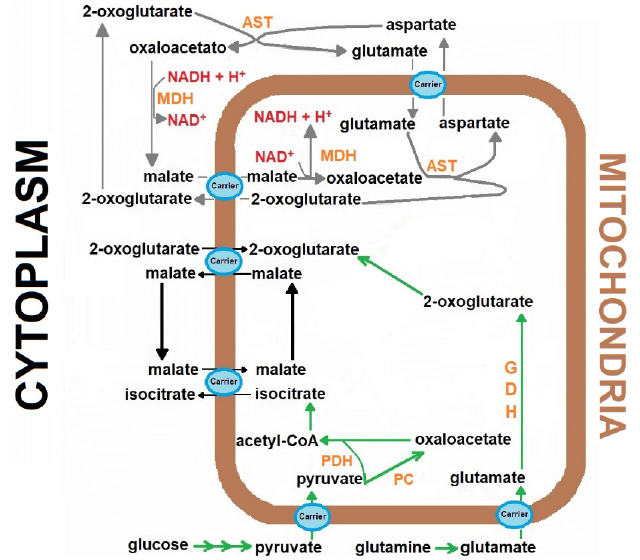
Figure 1. The role of the Malate-aspartate shuttle in the cardiomyocytes metabolism. The scheme represents the transport of the reducing equivalents from the cytoplasm to mitochondria in the heart, through mobilization of metabolites participating in the malate-aspartate shuttle. Abbrevia- tions (enzymes): aspartate aminotransferase (AST), Aspartate aminotransferase, GDH, Glutamic dehydrogenase, malate dehydrogenase (MDH), malate dehydrogenase, PC, Pyruvate carboxylase, PDH, Pyruvate dehydrogenase complex.